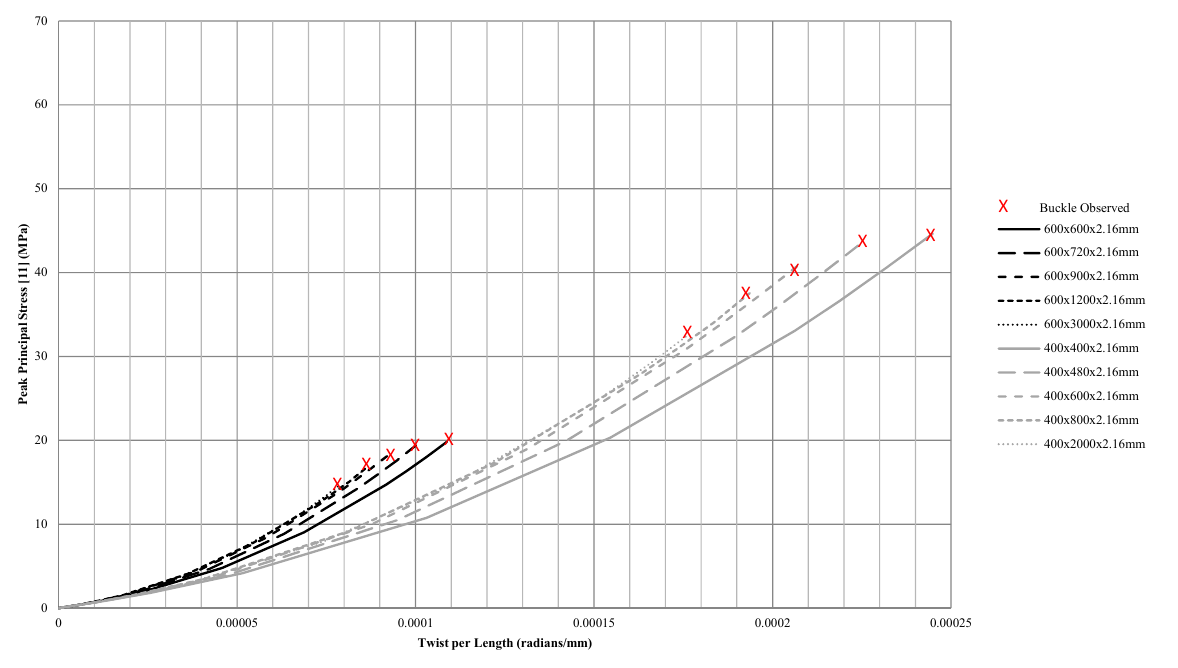
Fig. 14 Comparison for Buckling and Stress with No Transverse Load p=0kPa at t = 2.16mm, B = 400mm and B =